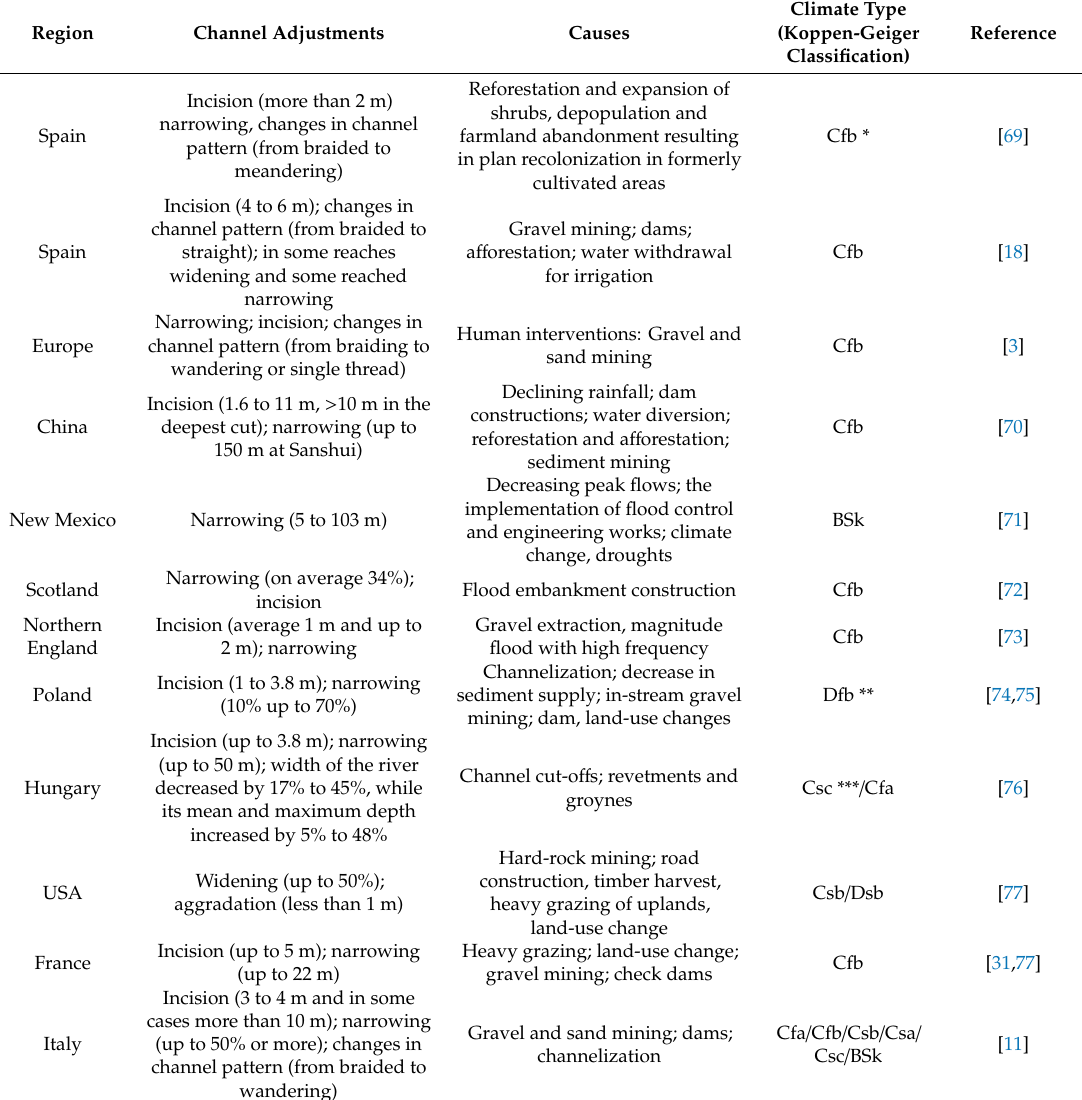
Table 3. Channel changes due to human activities: Case studies from di ff erent countries and